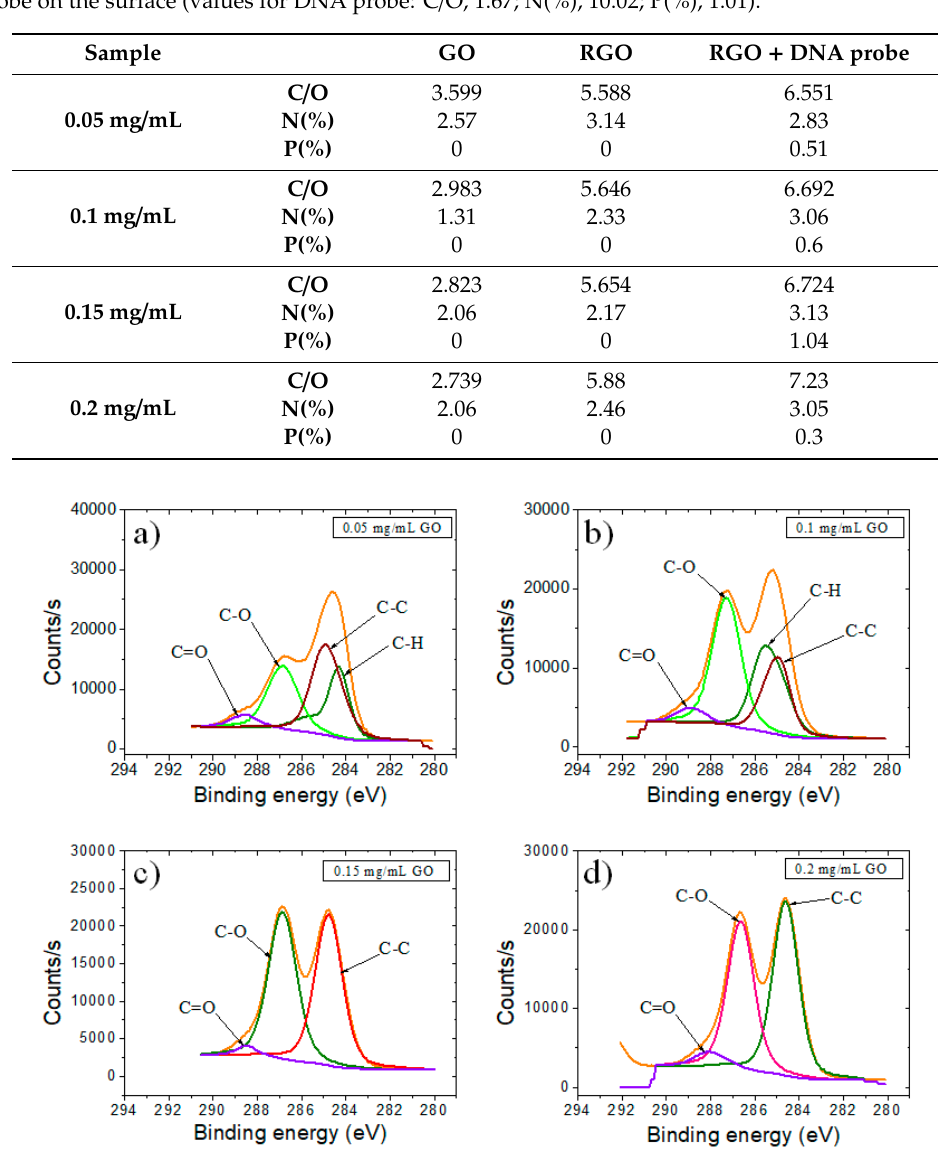
Table 1. Carbon to oxygen ratio, nitrogen and phosphorous content of electrodes modified with four di ff erent concentrations of GO, after electrochemical reduction and after immobilization of ssDNA probe on the surface (values for DNA probe: C / O, 1.67; N(%), 10.02; P(%), 1.01).